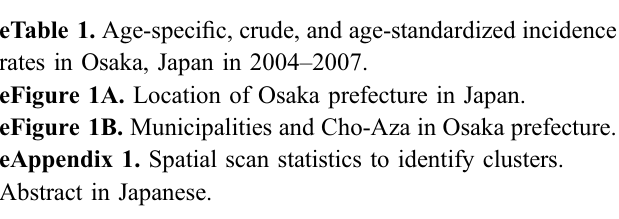
Distance from Radius of the factory the cluster (km)